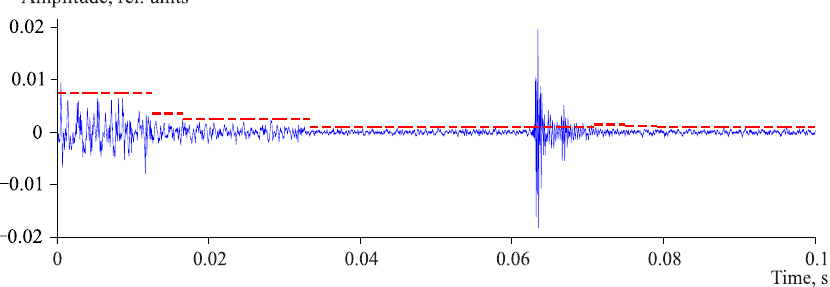
Figure 7. Example of threshold value adaptation to background noise level. Dashed red line is the